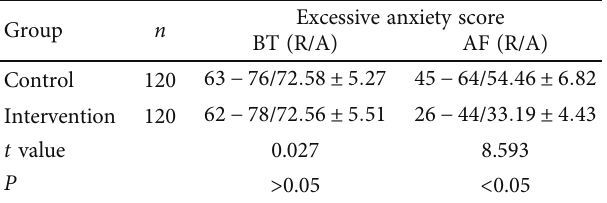
Table 2: Comparison of anxiety evaluation results of college students in the control and intervention groups before treatment (BT) and after treatment (AT) ( (cid:1) x ± s ). Note: R: range; A: average.